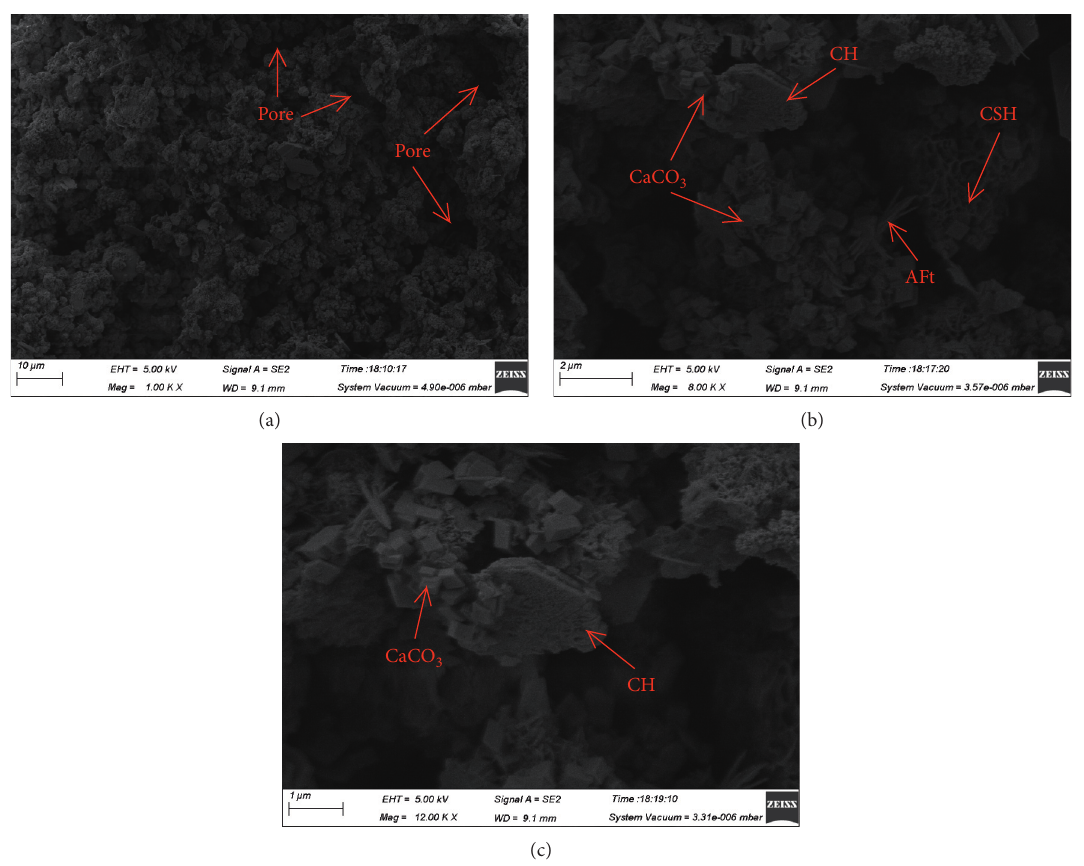
Figure 14: SEM images of the specimen for 7 days: (a) 1000x, (b) 8000x, and (c) 12000x.